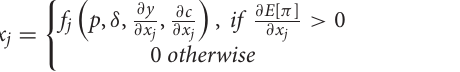
TABLE 2 | Estimated period that a Danish pig herd has a high Salmonella level. Shift of level Days Herds From 3 to 2 55.3 955 From 3 to 1 70.3 1,054 From 2 to 1 65.0 3,049 Own calculations based on data from the Danish Zoonosis Register. Data from 2011 to 2018. Only the 5,074 herds that have been in the dataset for at least 5 years from 2011 through 2018 are included in the